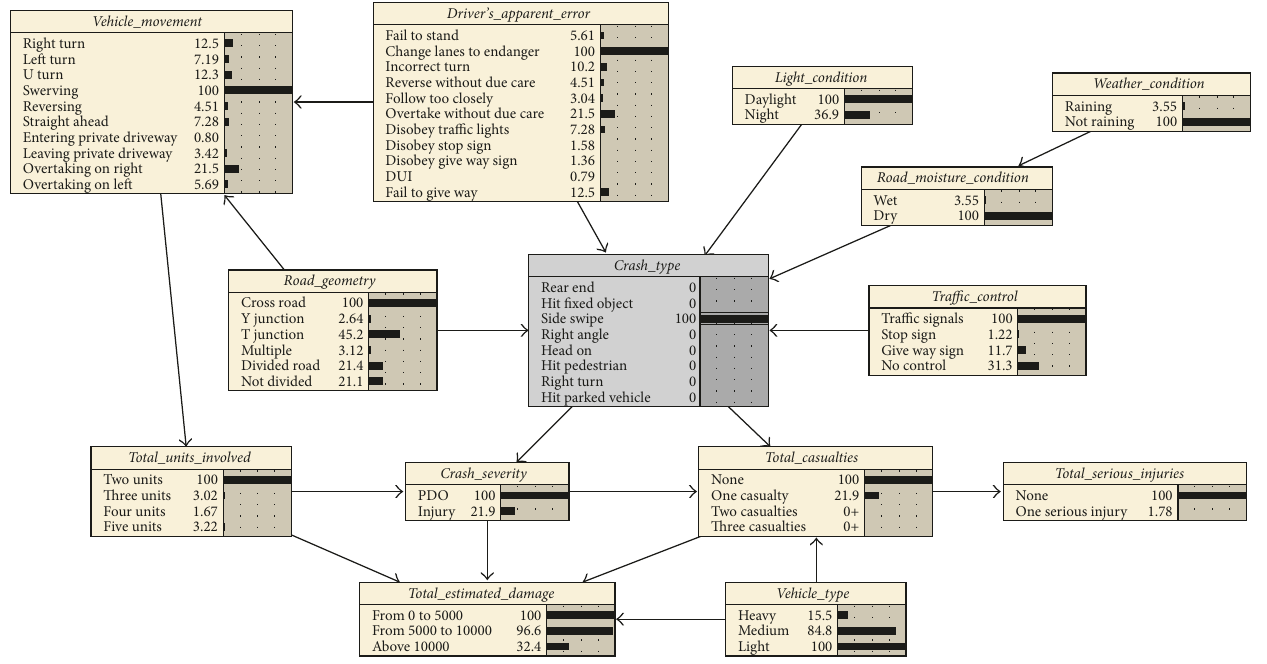
Figure 12: The most probable explanation when the evidence variable is “side